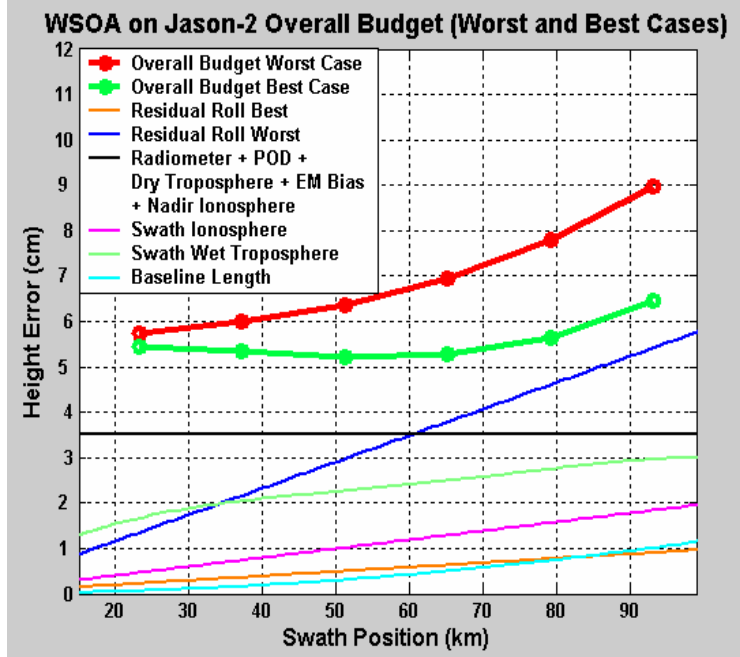
Figure 19. Global error budget of WSOA in worst and best cases for 16*14